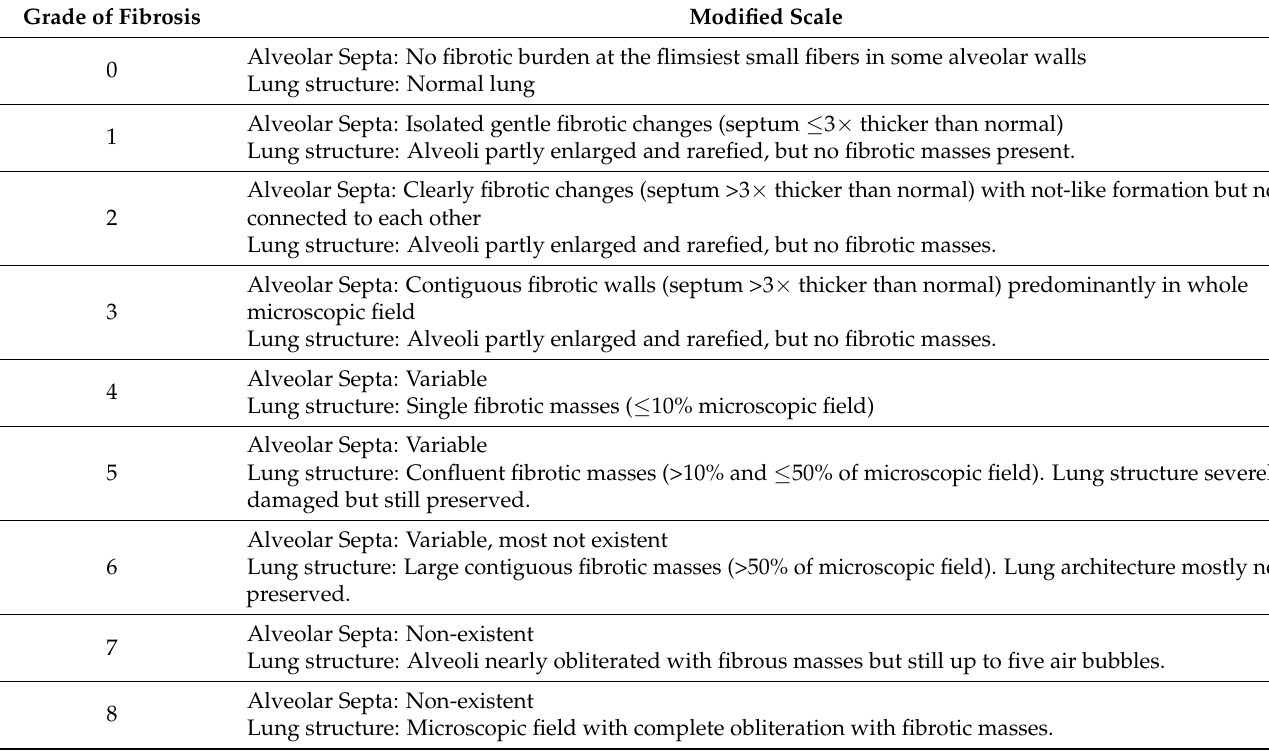
Table 2. Modified Ashcroft scale for histological grading of lung